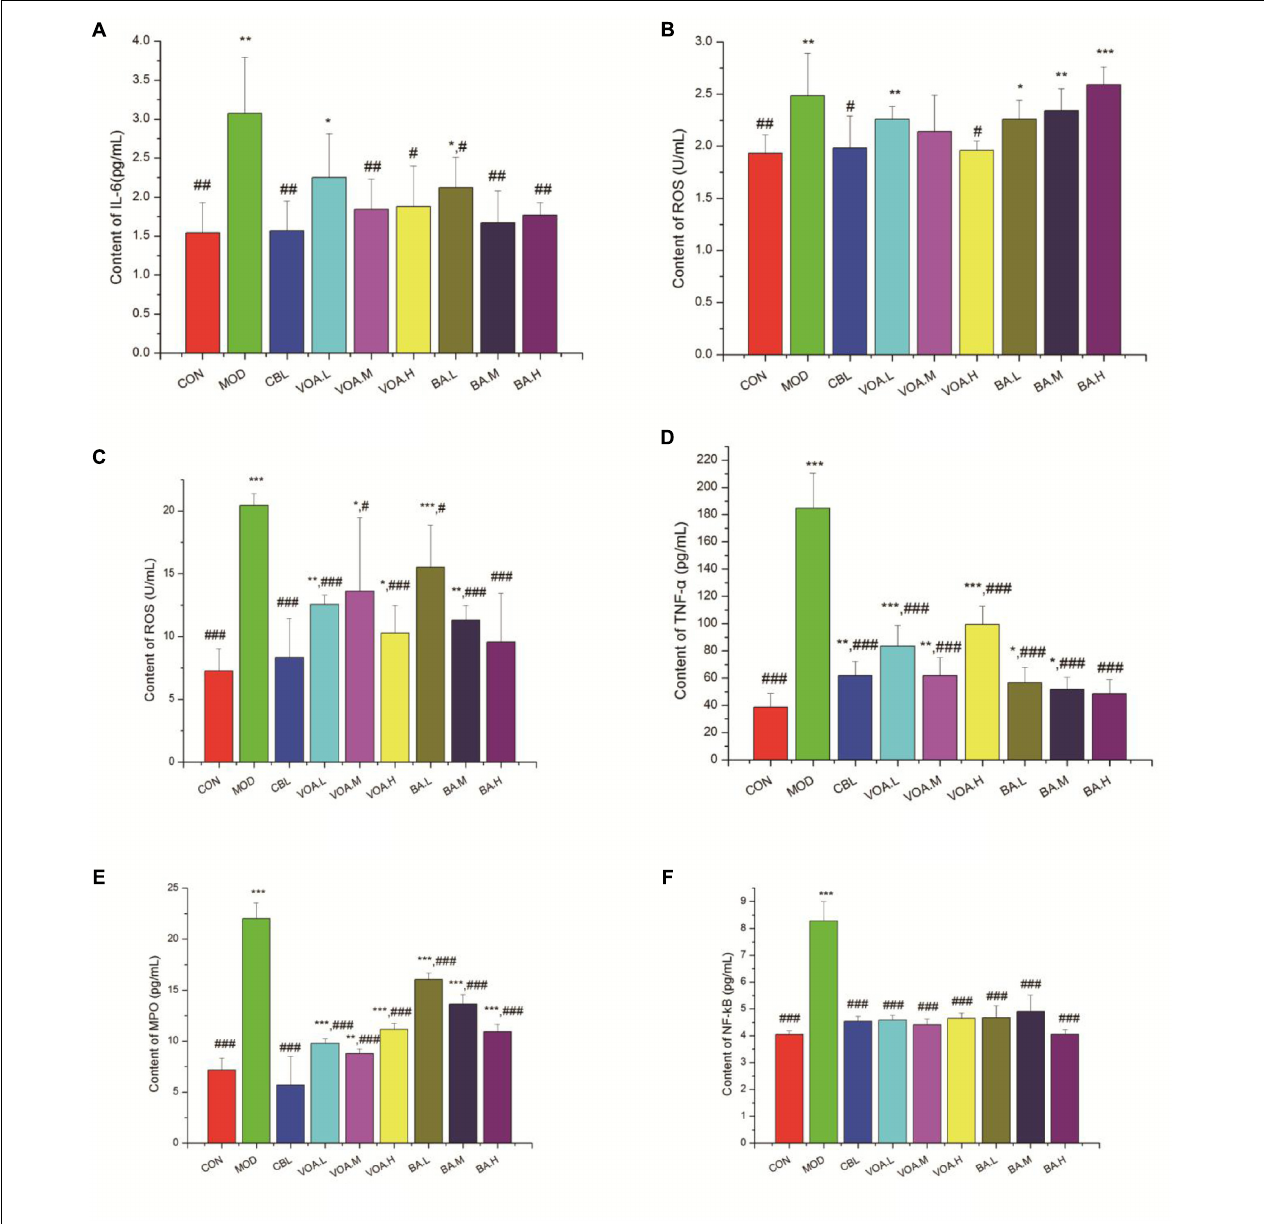
FIGURE 5 | Reduced IL-6, ROS, TNF- α , NF- κ B, and MPO after VOA and BA treatment in blood and small intestinal tissue ( n = 6). Increased (A) IL-6 and (B) ROS in blood after 5-FU. VOA and BA reduced inflammation. Increased (C) ROS, (D) TNF- α , (E) MPO, and (F) NF- κ B in small intestinal tissue after 5-FU. VOA and BA reduced pro-inflammatory cytokines. Values are means, with their standard deviation represented by vertical bars. Values are means ± SD. ∗ Significant difference compared to the controls. # Significant difference compared to the model and controls. ∗ p < 0.05, ∗∗ p < 0.01, ∗∗∗ p < 0.001, # p < 0.05, ## p < 0.01, and ### p <